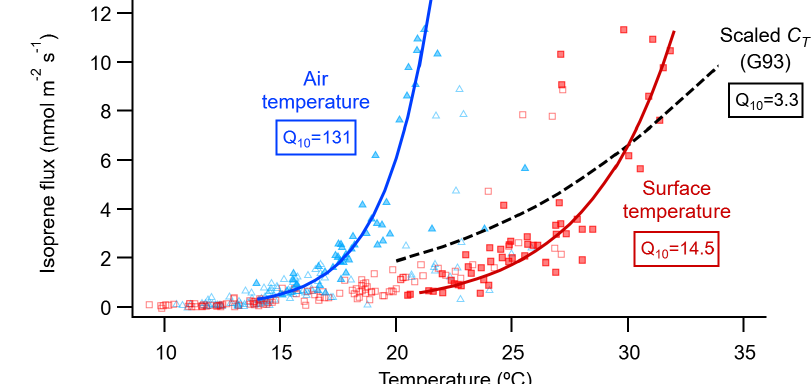
Figure 5. Relationship of the isoprene flux from the fen with the air temperature (blue triangles) measured at 2m height on the EC mast, and with the vegetation surface temperature (red squares) measured at the nearby ICOS station. The data points shown are all the July 30min fluxes that passed the EC quality criteria ( n = 161; open and closed symbols). Solid lines show the exponential equation F = F 0 · Q (T where F 0 is the isoprene flux rate at temperature T 0 ( = 0 ◦ C), F is the flux rate at temperature T ( ◦ C), and Q 10 is the temperature coefficient. F 0 and Q 10 were calculated by fitting the data to the linear equation log (F) = T · log (Q 10 )/ 10 + a 0 , where a 0 is the intercept at T = 0 ◦ C. For the fit, only fluxes not limited by light (when PAR was 1000µmolm − 2 s − 1 or more; n = 52; closed symbols) were binned into 1 ◦ bins (not shown). Then the average fluxes of the bins, excluding bins containing a single flux value, were used to perform an orthogonal distance regression weighed by the standard deviation of each bin average. As a reference, the dashed black line shows the relationship with leaf temperature of the temperature activity factor ( C T ) of the G93 model (Guenther et al., 1993), scaled to coincide with the surface temperature fit at 30 ◦